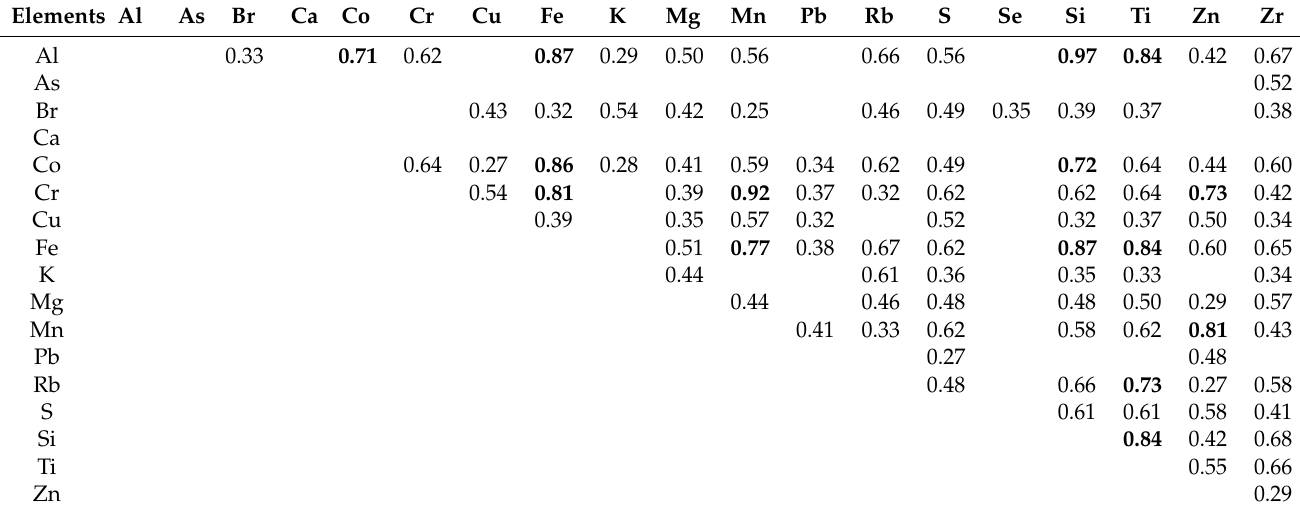
Table 2. Spearman correlations between elements in the exposed lichens, significant at the 0.05 level. Values in bold represent strong correlations (correlation coefficient above 0.70), while weak